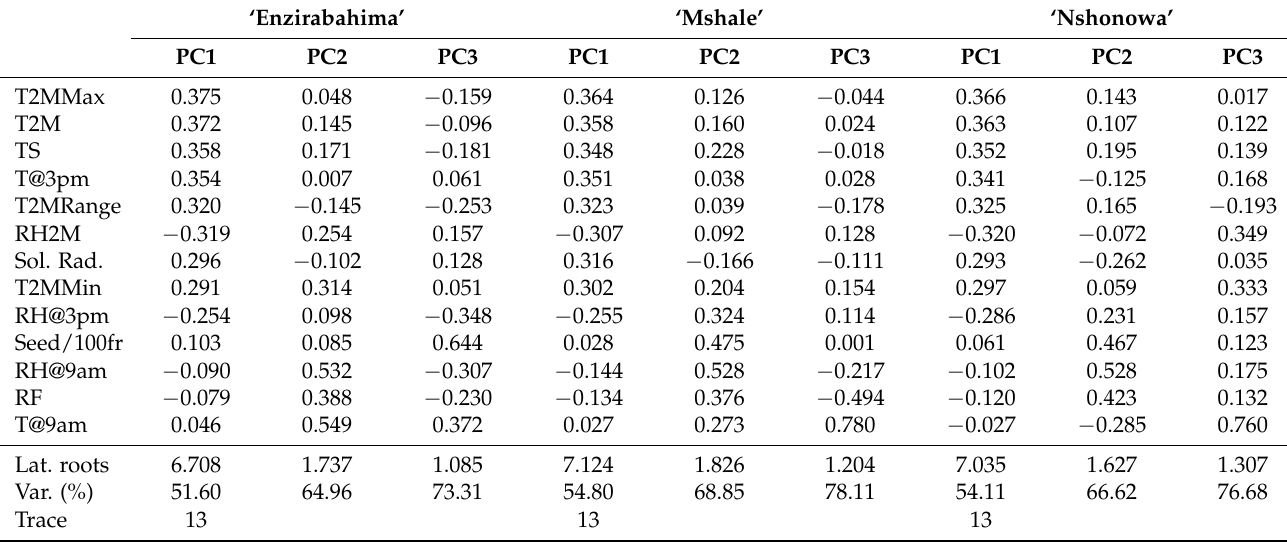
Table 5. Coefficients of first three principle components (PCs) of 13 variables of weather attributes and seed set per 100 fruit in ‘Nshonowa’ pollinated with ‘Calcutta 4 (cid:48) between January 2017 and January